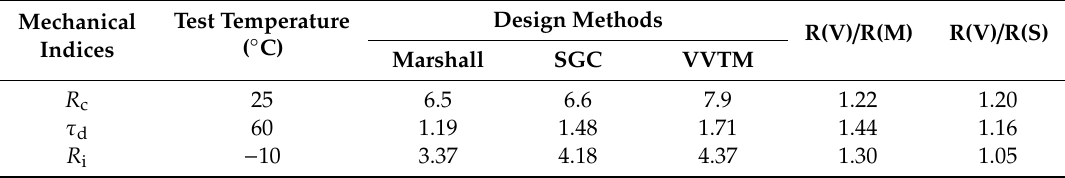
Table 12. Comparison of mechanical properties of the SMA-13 mixtures designed by di ff erent methods.